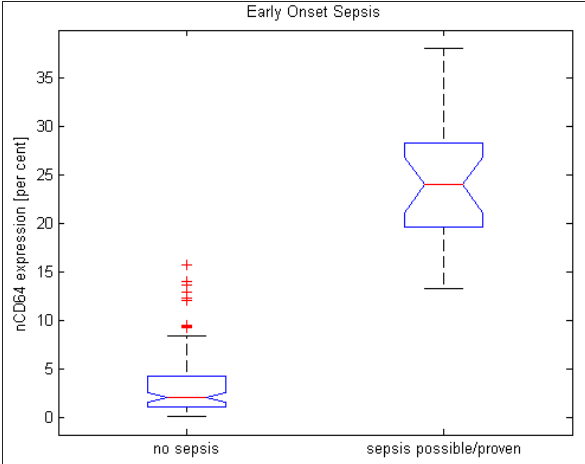
Fig. 1. nCD64 values: comparison of EOS patients with and without sepsis. The difference in nCD64 expression is statisti- cally significant at a significance level of 10 -13 .